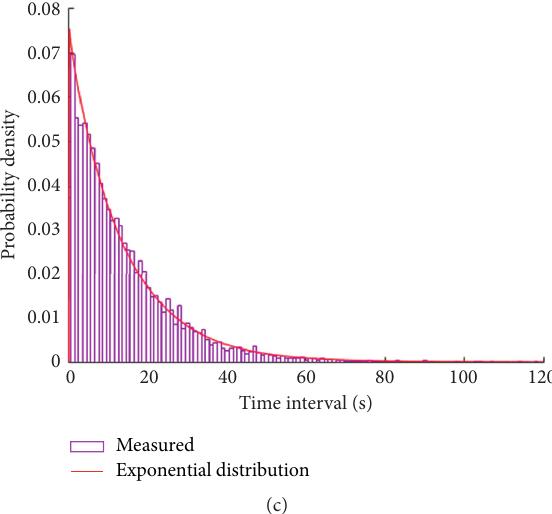
Figure 12: Examples of statistical models: (a) vehicle weight for type III; (b) vehicle speed for type III; (c) the time interval.